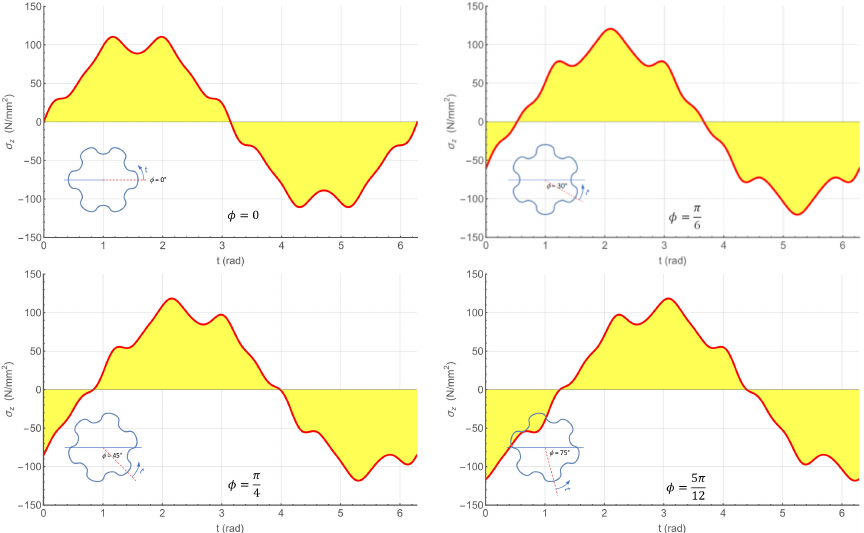
Figure 10. Distribution of the bending stresses on the M-T04 profile for several rotation angles according to Equation